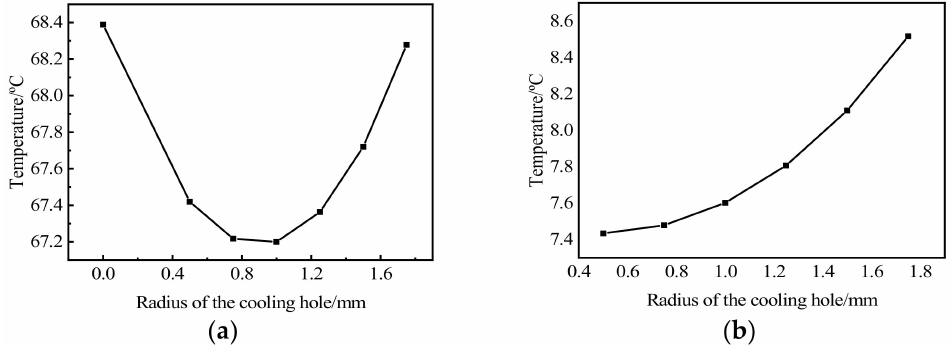
Figure 7. ( a ) Maximum temperature; ( b ) Temperature